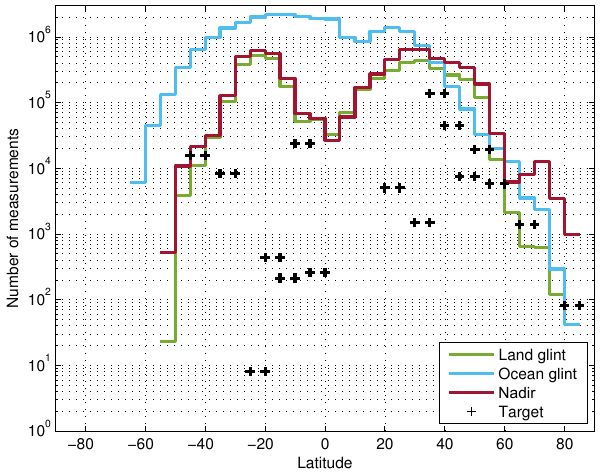
Figure 2. The zenith angles viewed during an OCO-2 target-mode maneuver over Lamont on 5 March 2015. The spacecraft “nods” across the ground target as it rotates overhead. The colors and de- creasing size of the points indicate the time of the measurement. The top inset shows the locations of the measurements in latitude and longitude. The eight footprints are apparent in the roughly N– S stripes. There are 3473 soundings with a retrieval zenith angle of less than 40 ◦ in this target-mode maneuver, most of which are obscured in the inset by the later, nearly spatially coincident sound-